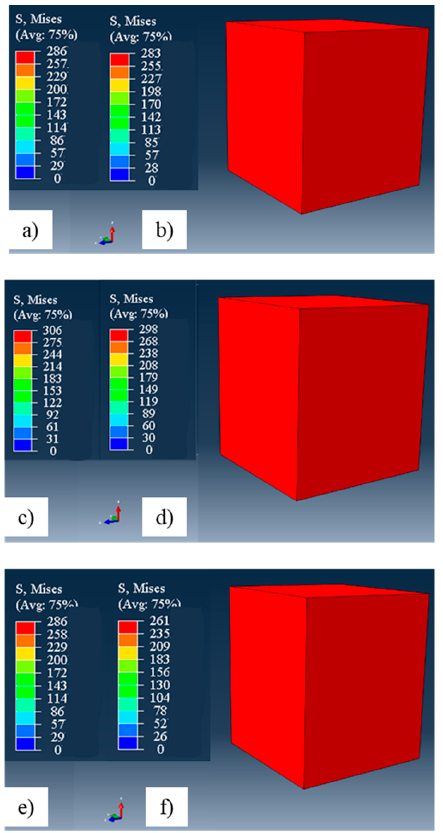
Figure 16. FE Results of the Alloy Set A3.1: ( a ) fv = 0.0165, ( b ) fv = 0.0193, A3.2: ( c ) fv = 0.002, ( d ) fv = 0.004, and A3.3: ( e ) fv= 0.018, ( f ) fv = 0.0366.